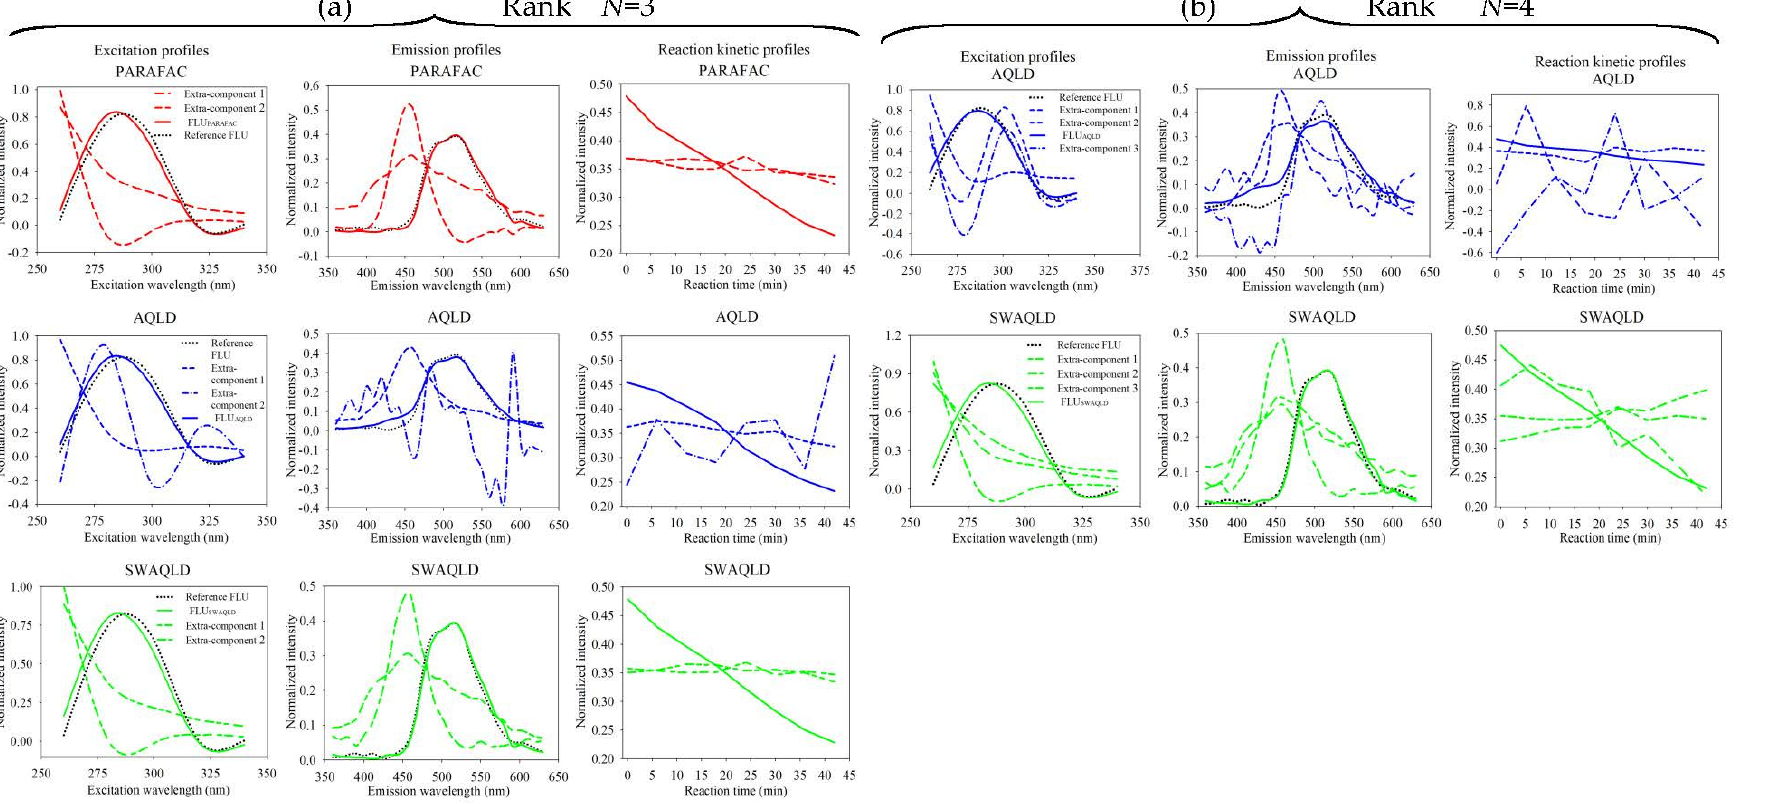
Figure 6. Resolved excitation, emission, and kinetic profiles, normalized to unit length obtained from PARAFAC, AQLD and SWAQLD for the analysis of four-way phosphorescence data of wastewater samples with a rank N = 3 ( a ) or 4 ( b ). The black dotted lines denote the FLU reference profiles. The red, blue, and green solid lines represent the FLU-resolved profiles obtained from PARAFAC, AQLD, and SWAQLD, respectively. Other extracted profiles represent additional extracted components.